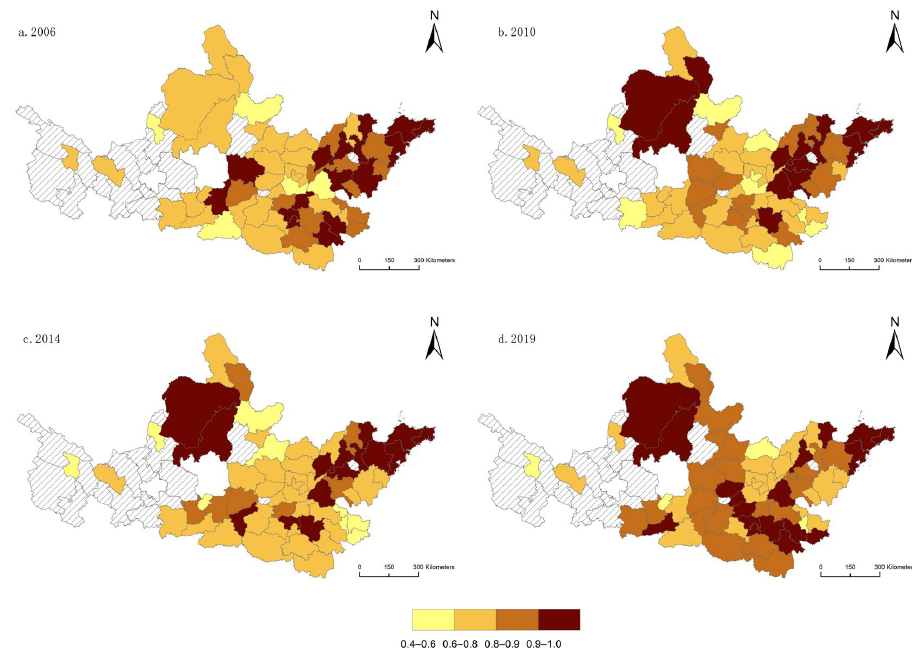
Figure 8. The degree of spatial coupling of urbanization efficiency and ecological efficiency in ( a ) 2006, ( b ) 2010, ( c ) 2014, and ( d ) 2019 in the Yellow River basin, China. Overall, the coupling relationship between the two is an N-type relationship, with the trend of first rising, then falling, and then rising. Spatially, the coupling degree of the upper and lower reaches of the Yellow River basin, China, is higher than that of the middle reaches of the Yellow River basin, China. During the period, there were fluctuations in each city. Hubao-Eyu urban agglomeration is represented by Ordos City and Yulin City: the spatial coupling degree is the highest, and the urbanization efficiency and ecological efficiency are maintained at a high level. There is a certain degree of fluctuation in cities such as Linfen City, Bozhou City, and Kaifeng City around 2006: the coupling degree of these areas is higher, but the value of its urbanization efficiency and ecological efficiency is at average; with the acceleration of the urbanization process, the urbanization efficiency gradually exceeds the ecological efficiency, the spatial coupling degree is unbalanced, and the degree of coupling decreases accordingly. After 2019, with the implementation and development of ecological civilization construction, ecological efficiency has increased year by year, and the spatial coupling between the two has also increased. In Luoyang